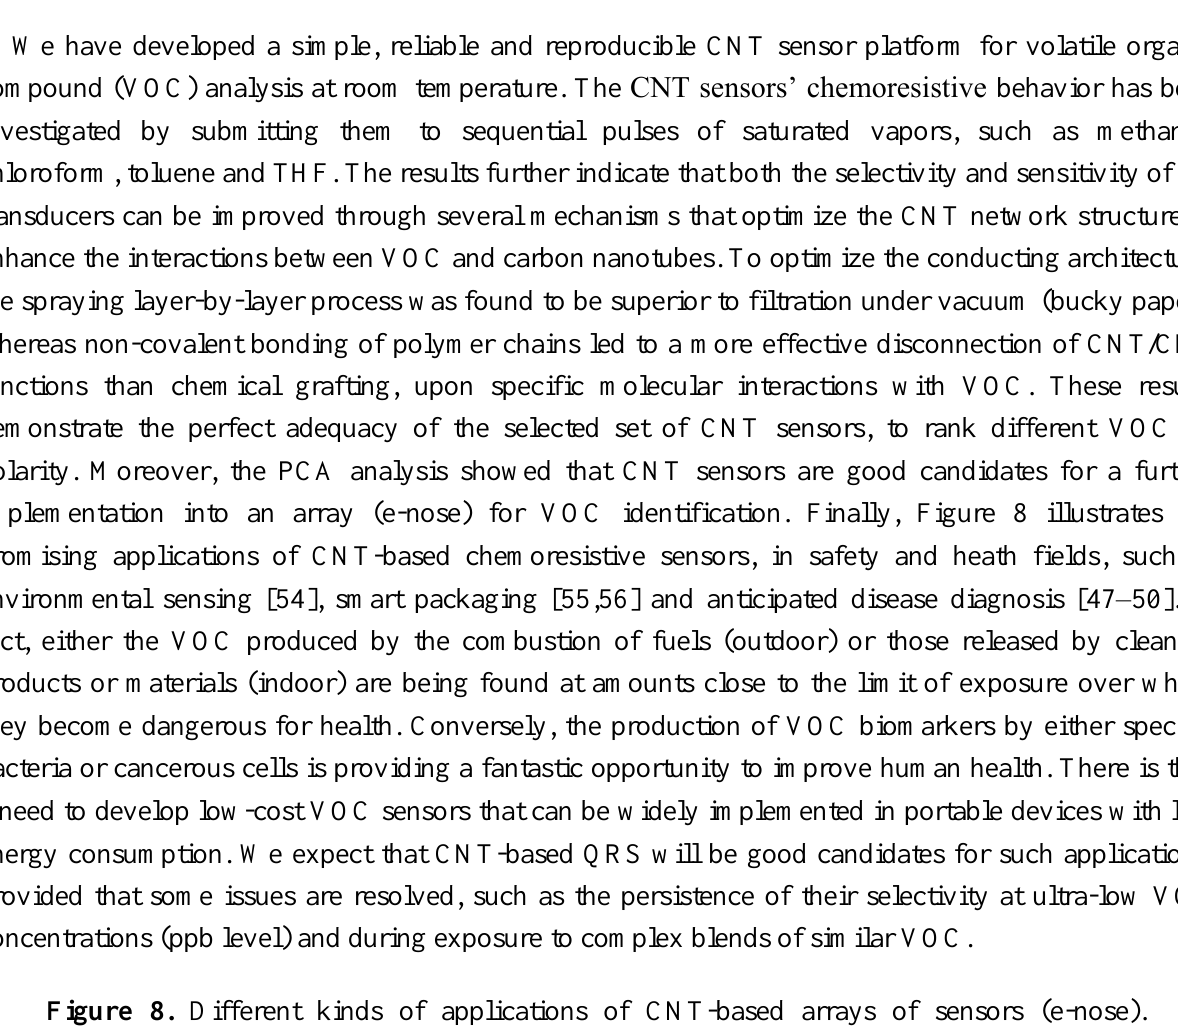
Figure 8. Different kinds of applications of CNT-based arrays of sensors (e-nose). ( Left ) Environmental monitoring to evaluate the level of exposition to toxic VOC